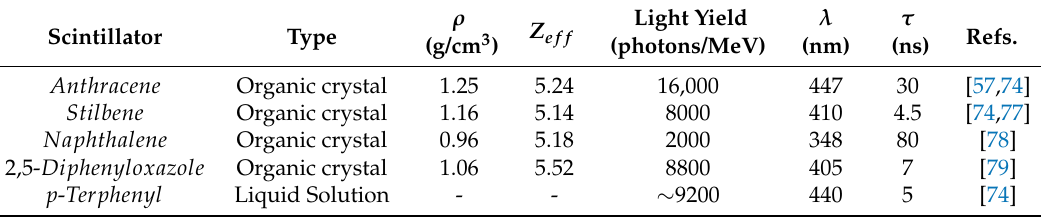
Table 2. Overview of some organic scintillators. Beside energy resolution, the same convention as in Table 1 is